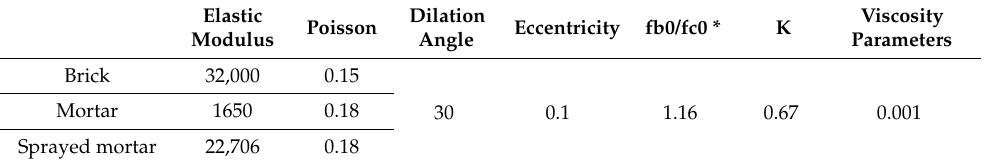
Table 10. Summary of material